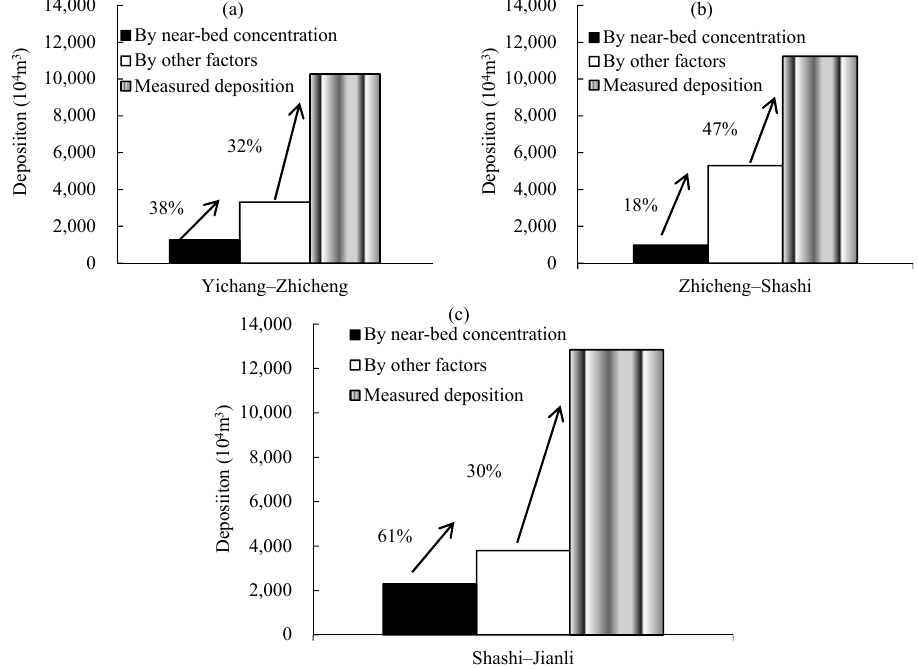
Figure 10. Contributing ratios of near-bed sediment concentration on total deposition estimation, at three sites, ( a ) the Yichang – Zhicheng, ( b ) the Zhicheng – Shashi, and ( c ) the Sahshi – Jianli reaches, based on data measured during 2002 – 2008 (from Yuan et al. [26]).